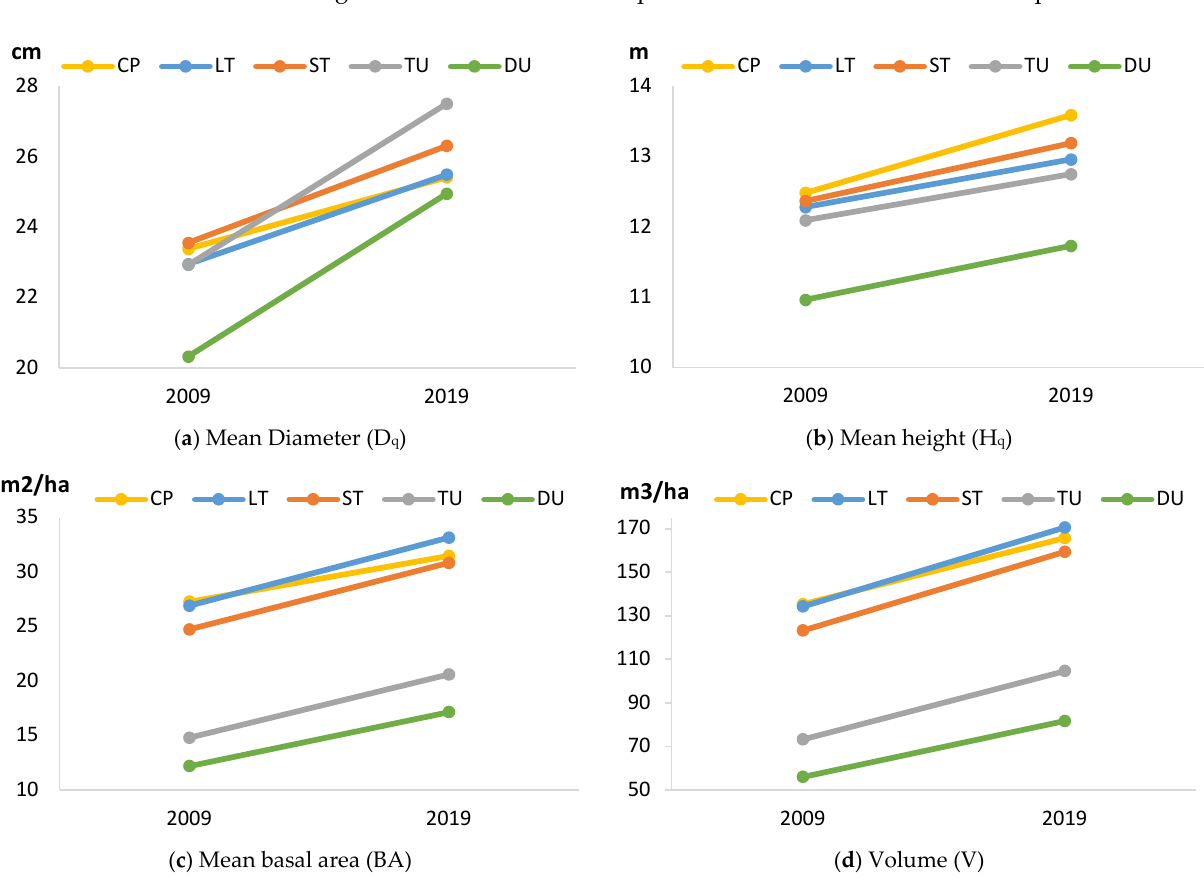
Figure 4. Changes in the different parameters by type of treatment between 2009 (after the applied treatment) and 2019.